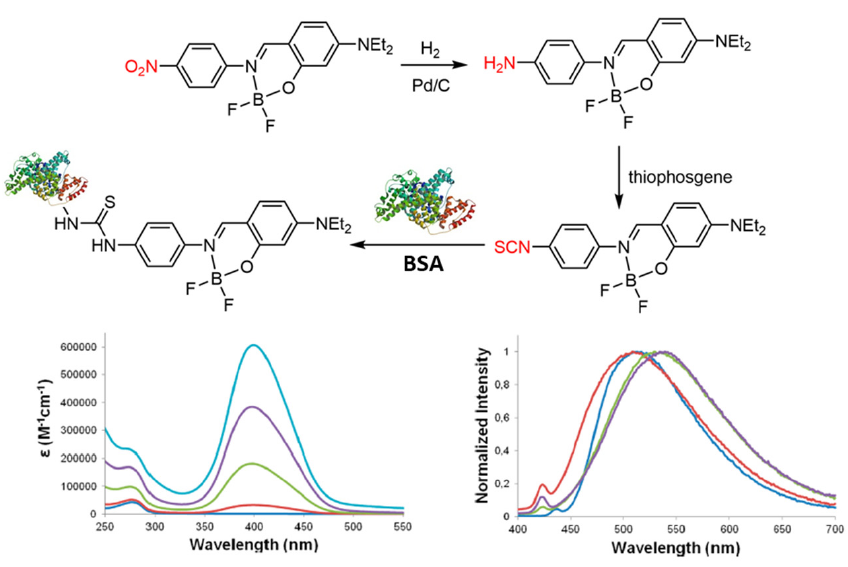
Figure 3. Postfunctionalization on the boranils core and application to the labelling of Bovine Serum Albumine (BSA) protein [45]. (blue) BSA, (red) BSA + 1 eqt of boranil, (green), BSA + 5 eqts of boranil, (purple), BSA + 10 eqts of BSA, (light blue) labeled BSA. Adapted from Reference [45], Copyright 2012 American Chemical Society.